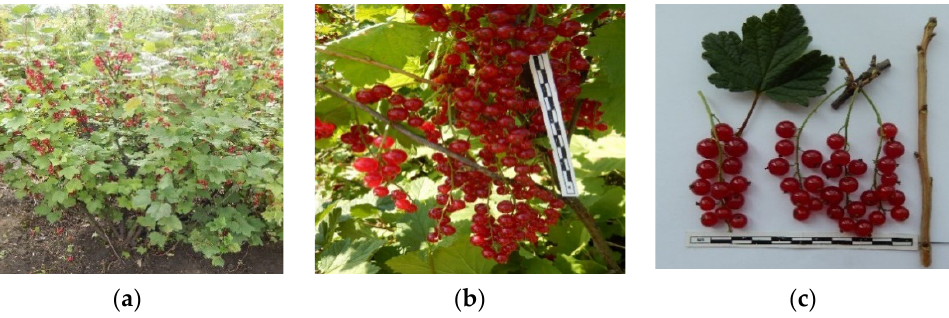
Figure 9. ( a ) Bush habitus; ( b ) fruiting; and ( c ) pomological traits of ‘Podarok Pobediteliam’ (genotype 44-5-2). Selection plot at the Russian Research Institute of Fruit Crop Breeding (VNIISPK).